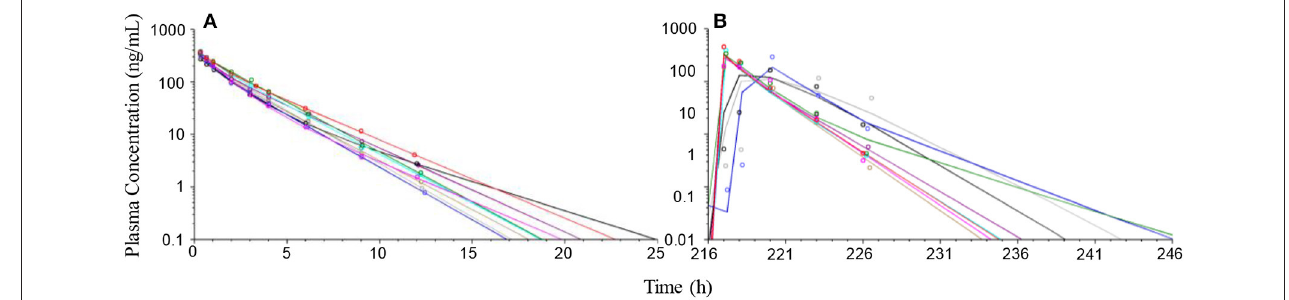
FIGURE 3 | Observed (symbols) and model predicted (lines) prednisolone plasma concentration-time courses following administration of 1 mg/kg prednisolone succinate intravenously (left plot A ) and after the last dose (216h after first dose) of approximately 1 mg/kg for 10 consecutive daily oral doses (right plot B ) to 9 beagle dogs. Twenty four hours after IV-administration or 24h after the last dose per os (240h after the first dose) prednisolone plasma concentration was below the lower limit of quantification (0.5ng/mL) in all dogs.